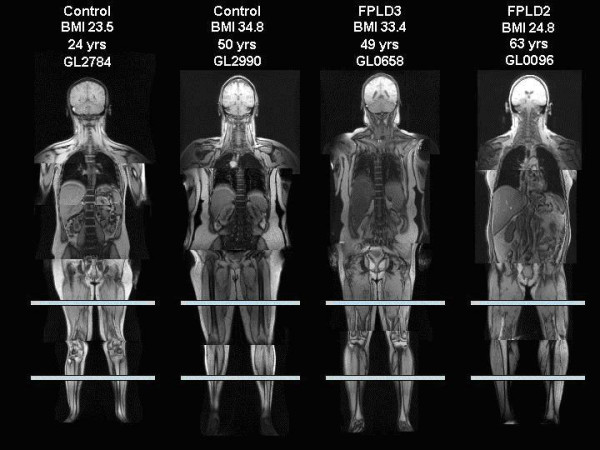
Full body coronal magnetic resonance image of the subjects in the study and the assigned survey fields in the mid-calf and mid-thigh. On these survey images the horizontal bars indicate the location of the mid-calf and mid-thigh sections, positioned based on reference anatomical features. The mid-point of the tibia was selected for "mid-calf" measurements and the mid-point of the femur was selected for "mid-thigh" measurements. Subjects from left to right are normal controls, GL2784 and GL2990, followed by the FPLD3 patient (GL0658) and FPLD2 patient (GL0096).